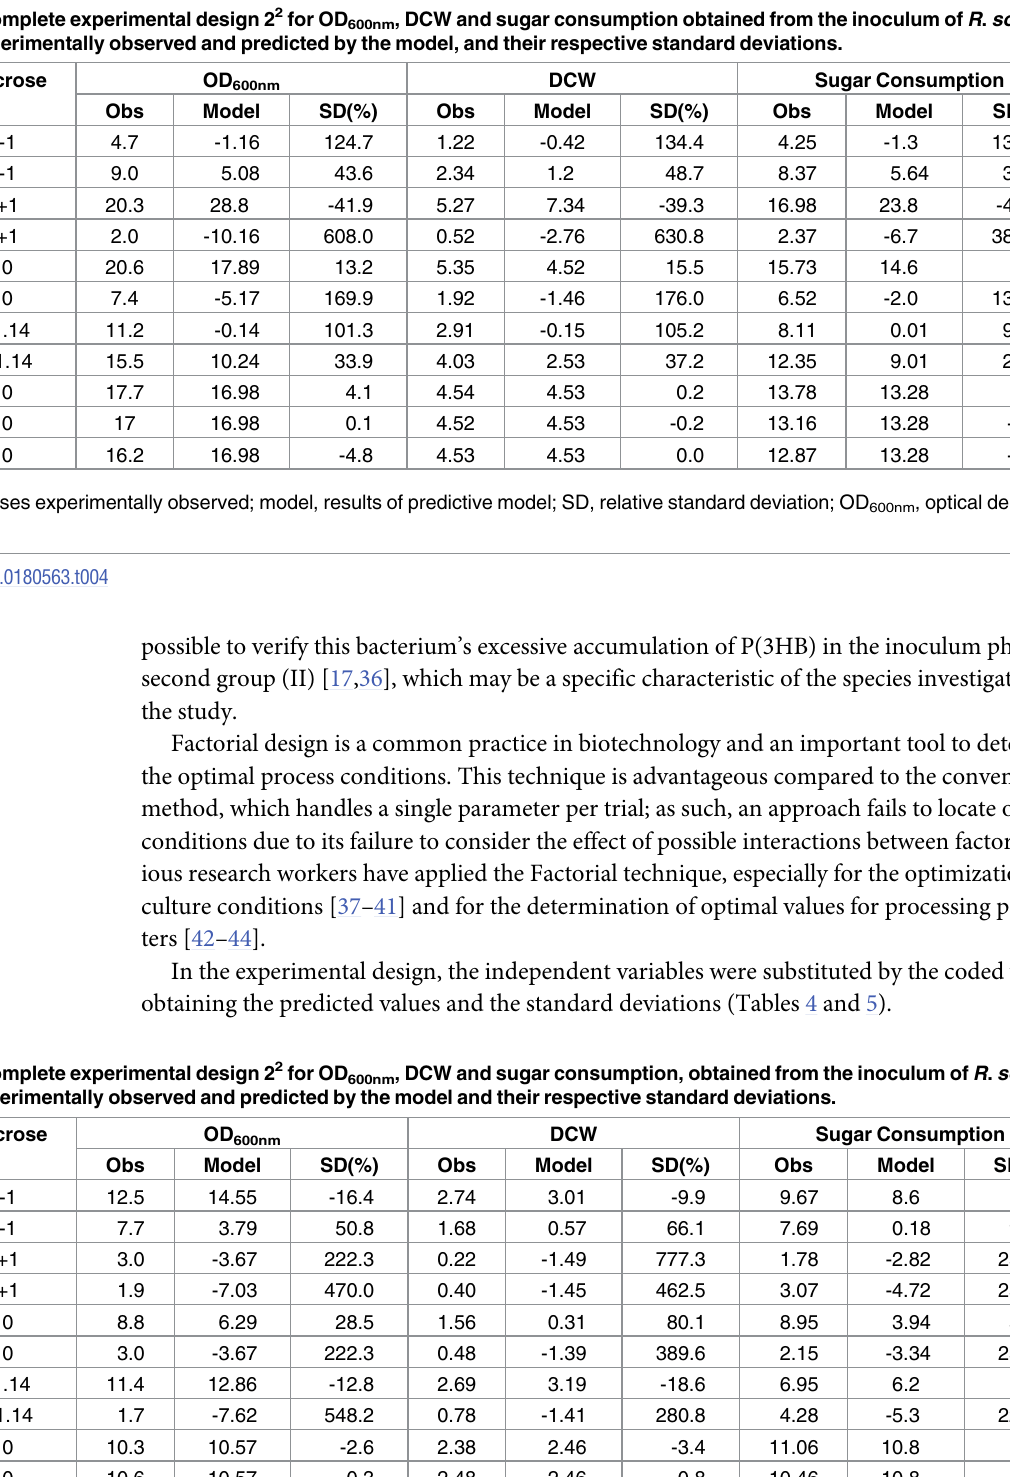
Table 4. Responses of the complete experimental design 2 2 for OD 600nm , DCW and sugar consumption obtained from the inoculum of R . solana- cearum RS with sucrose, experimentally observed and predicted by the model, and their respective standard deviations.